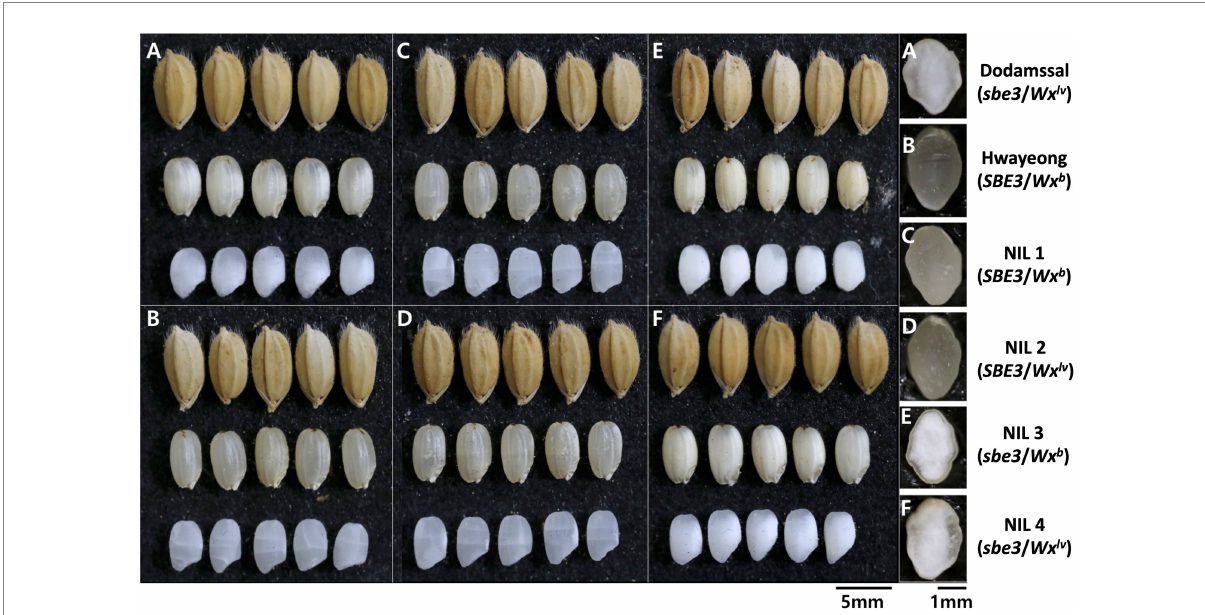
FIGURE 1 Comparison of seed morphology of two parental lines and four near-isogenic lines (NILs). (A) Dodamssal, (B) Hwayeong, (C) NIL 1 ( SBE3 / Wx b ), (D) NIL 2 ( SBE3 / Wx lv ), (E) NIL 3 ( sbe3 / Wx b ), and (F) NIL 4 ( sbe3 / Wx lv